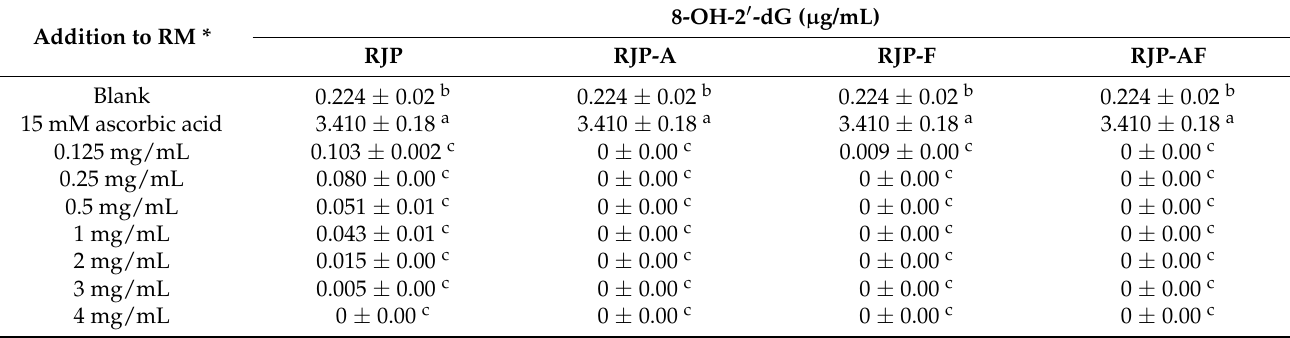
Table 3. Effect of royal jelly protein and different hydrolysates obtained by alcalase and flavourzyme on the oxidation of 2 (cid:48) -dG to 8-OH-2 (cid:48) -dG induced by the Fenton reaction.